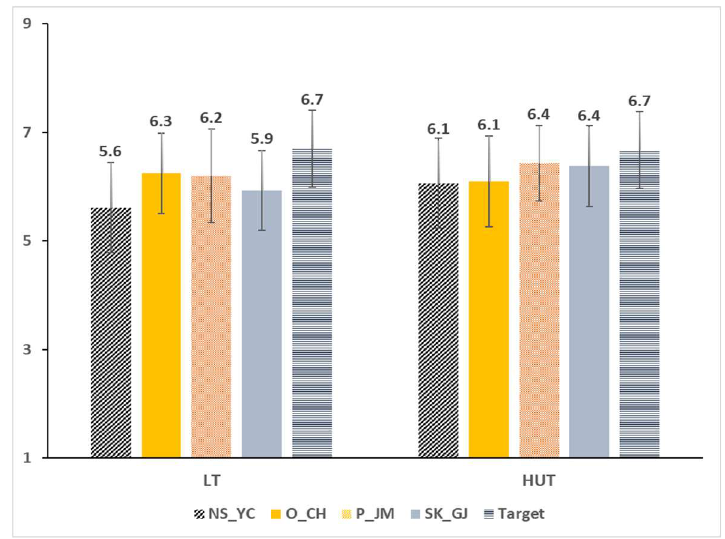
Figure 3. Mean overall liking scores of vegan ramen samples in the lab condition test ( left ) and in the home-used test condition ( right ).